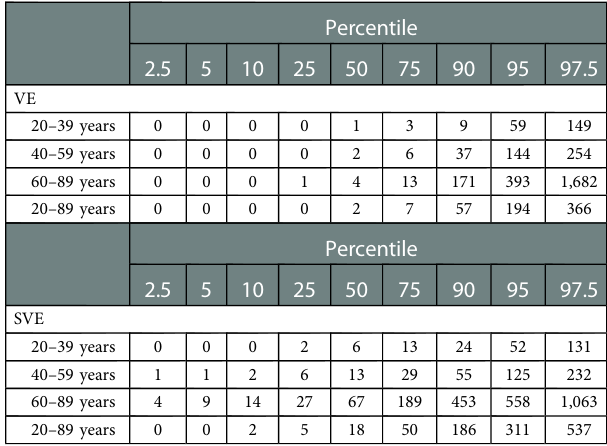
TABLE 3 Percentile of the frequency of simple ectopy (reference value of ectopy) ( N =365).